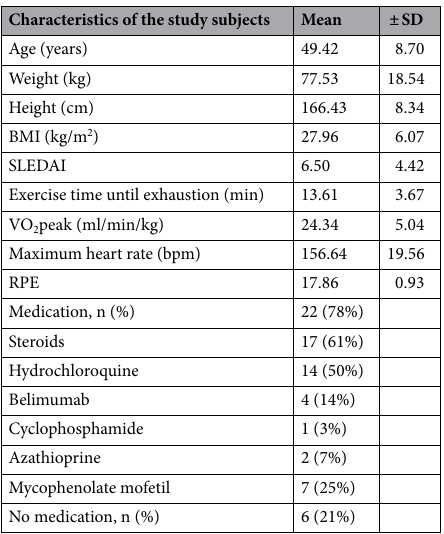
Table 1. SLE patients’ characteristics. SLEDAI systemic lupus erythematosus disease activity index, BMI body mass index, RPE rating of perceived exhaustion.